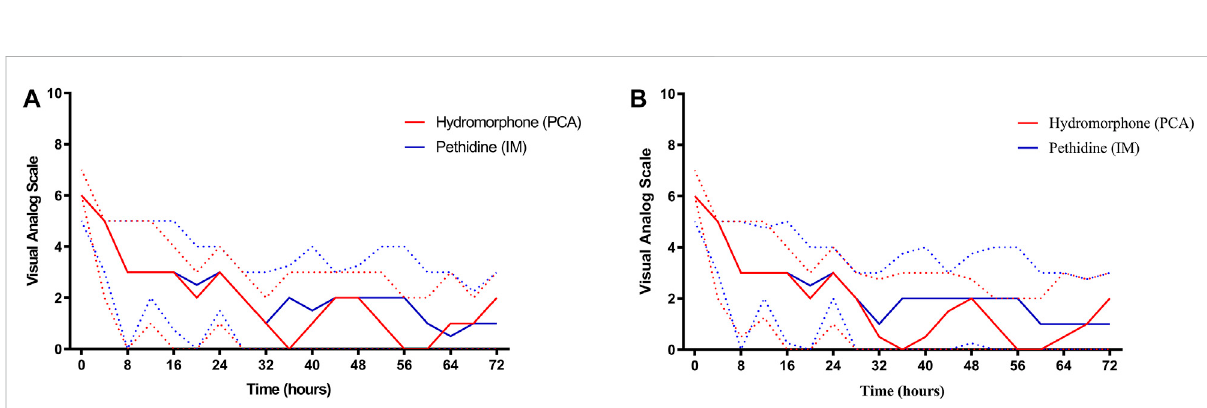
FIGURE 2 Trends of VAS scores in the two groups. Solid red and solid blue lines represent changes in VAS score over 72 h in the hydromorphone and pethidinegroups,respectively. DottedredanddottedbluelinesrepresenttheinterquartilerangeofVASscoresinthehydromorphoneandpethidine groups, respectively. (A) VAS score based on intention-to-treat analysis. (B) VAS score based on per-protocol analysis. PCA, patient-controlled analgesia, IM, intramuscular, VAS, visual analog scale